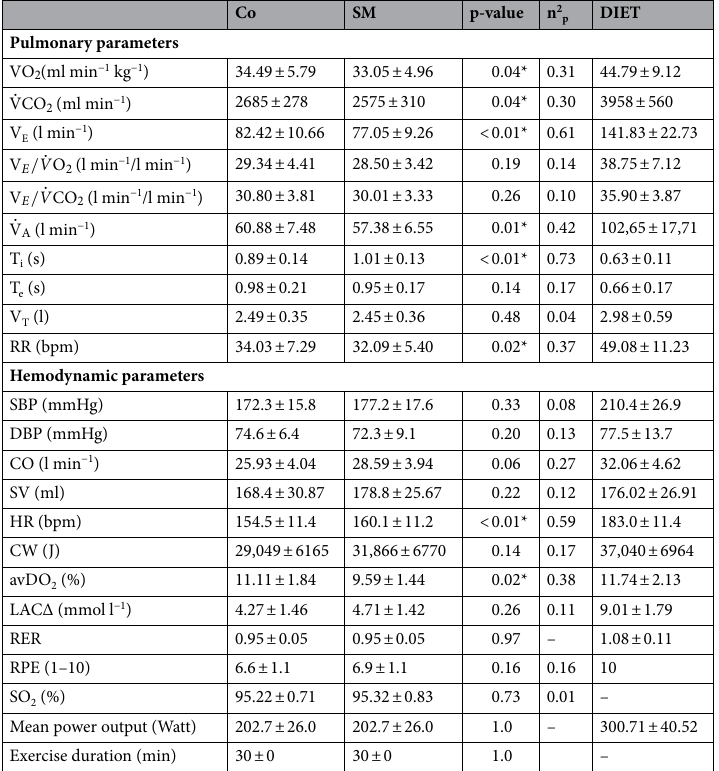
Table 2. Mean values with and without SMs during the 30 min continuous tests (n = 13; excluding the warm-up and recovery phase). Values are given as the means and standard deviations. The values are presented as means and standard deviations. DIET double incremental exercise test; Co control; SM surgical mask; ˙ VCO IET incremental exertion test; VO 2 oxygen uptake; 2 carbon dioxide production; V E minute ventilation; V E / VO 2 refers to the number of liters of ventilation per liter of oxygen consumed; V E / ˙ VCO 2 refers to the ˙ V number of liters of ventilation per liter of carbon dioxide A alveolar ventilation; RR respiratory rate; V T tidal volume; T i inspiratory time; T e expiratory time; SBP systolic blood pressure (5-min interval); DBP diastolic blood pressure (5-min interval); SV stroke volume; CO cardiac output; HR heart rate; avDO 2 arteriovenous oxygen difference; RER respiratory exchange ratio, LAC blood lactate concentration (5-min interval); SO 2 % oxygen saturation RPE rating of perceived exertion (5-min interval); n 2 p . *Significant differences from